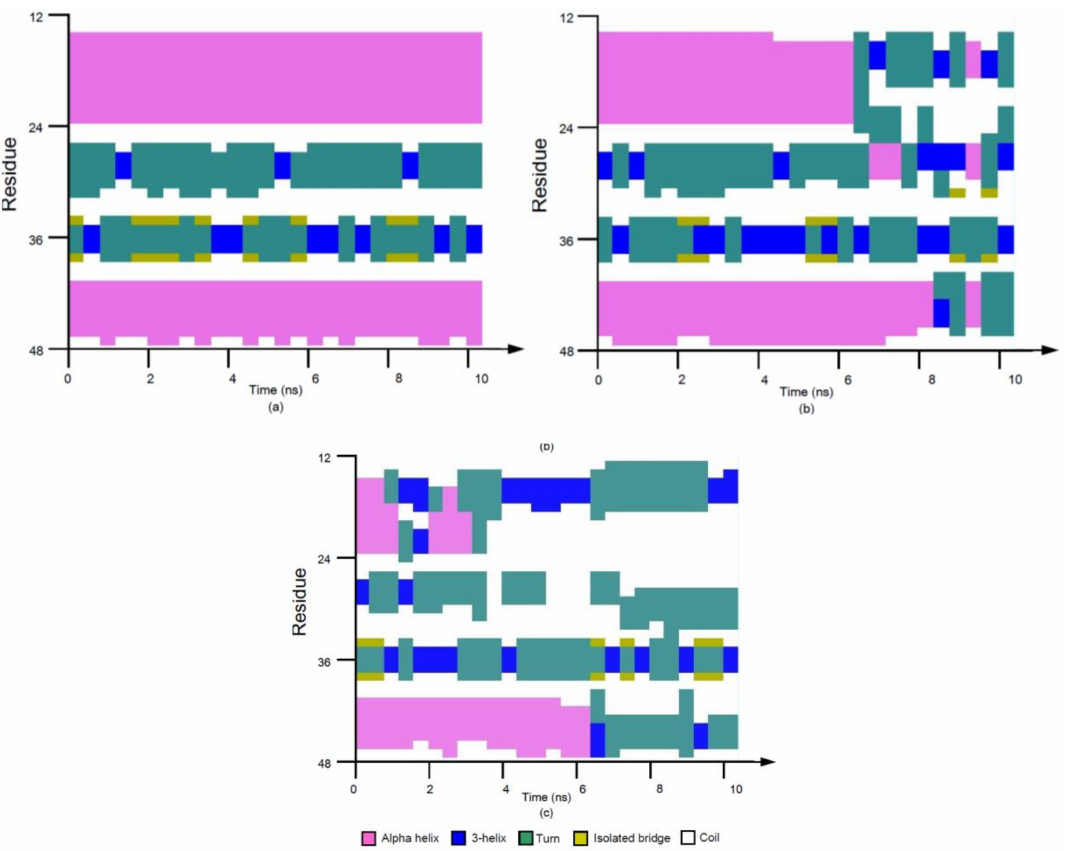
Figure 3. (Color online) Stride evolution of secondary structures of the protein 1BBL exposed in the external electric fields along the z -direction with the strength ( a ) Ez = 0 V/nm, ( b ) Ez = 0.5 V/nm, and ( c ) Ez = 0.6 V/nm,